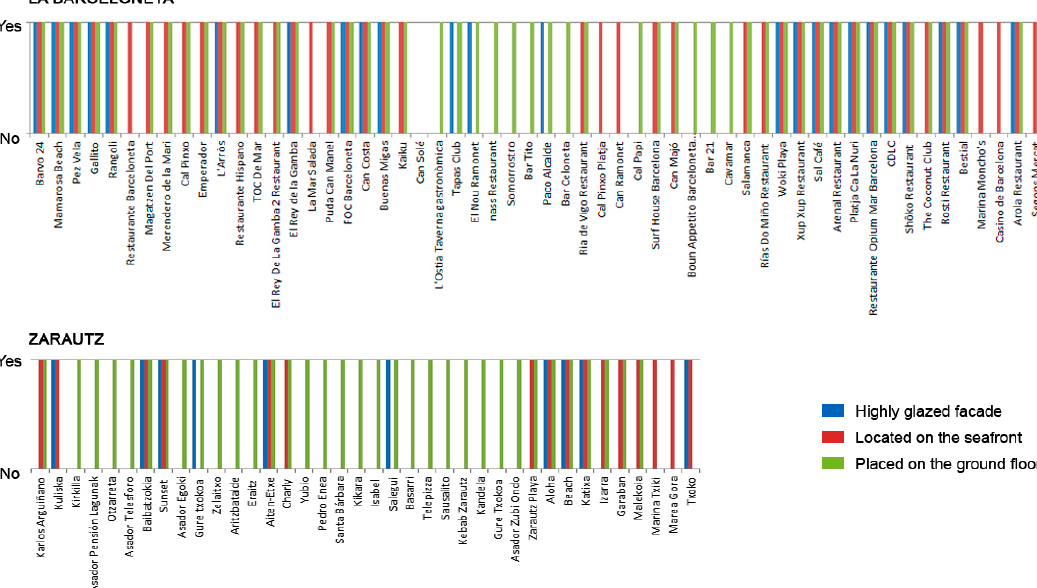
Figure 1. Glazed façades of restaurants without overall building façade integration. In the first row, restaurants with glazed façades in Zarautz (nearby Bilbao); in the second row, restaurants with glazed façades in La Barceloneta (neighborhood of